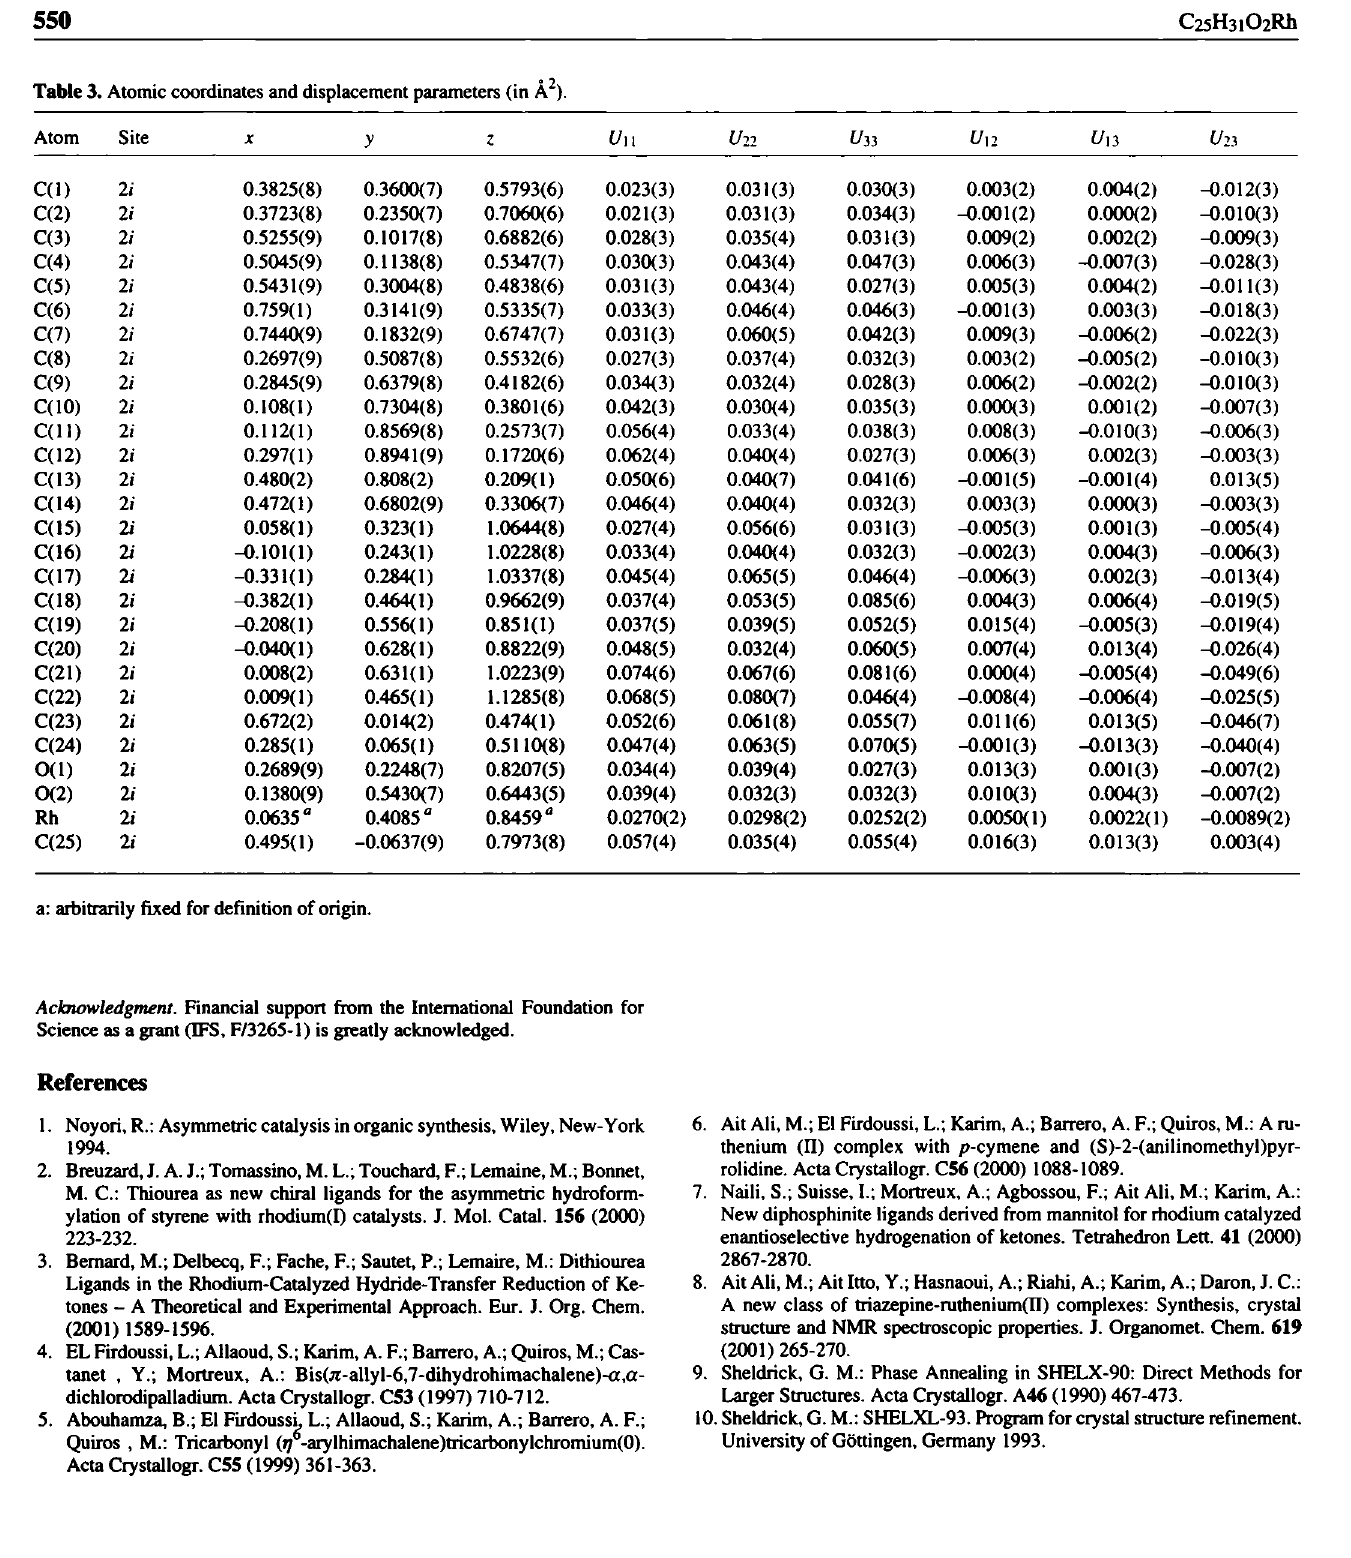
Table 3. Atomic coordinates and displacement parameters (in A 2